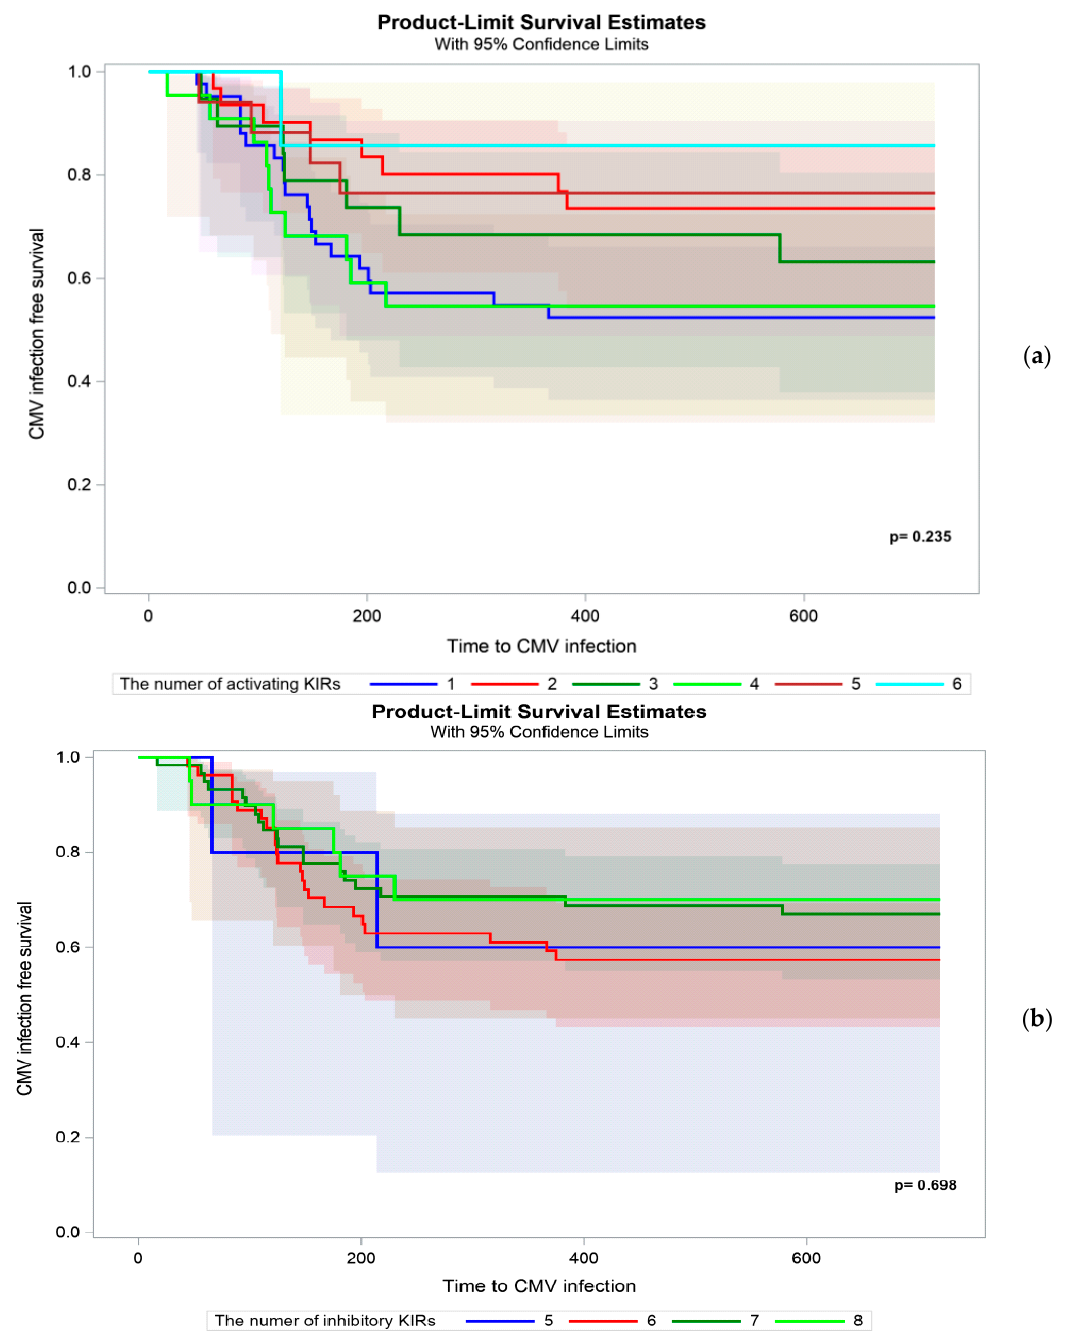
Figure 2. Occurrence of CMV infection in kidney transplant recipients stratified by the cumulative number of ( a ) activating and ( b ) inhibitory KIR genes .